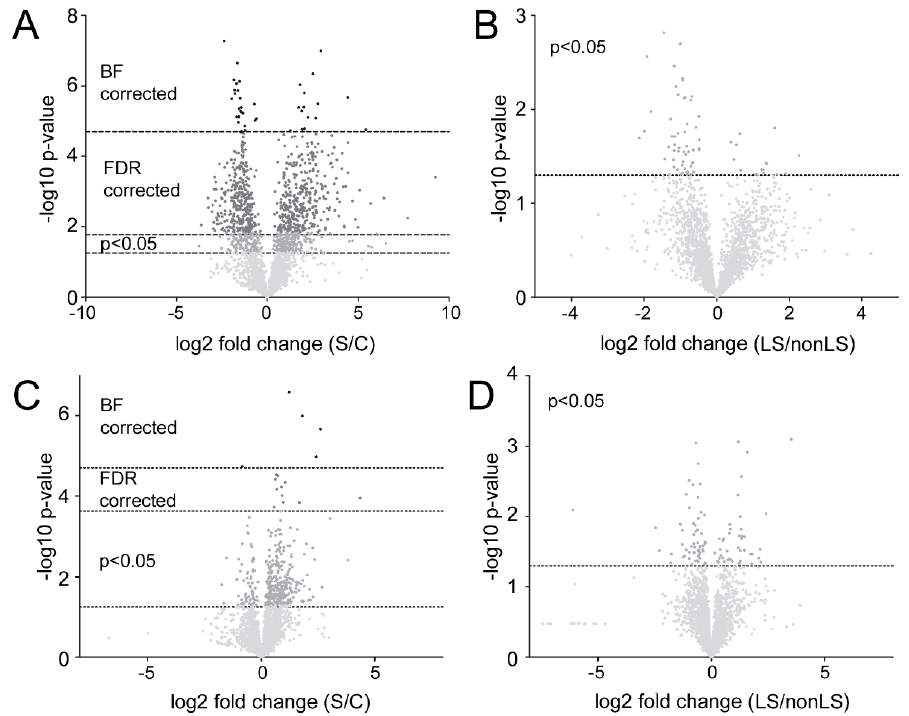
Figure 4. Volcano plots of the data. ( A ) Volcano plot of BALF-controls vs. BALF-sarcoidosis. Negative fold change signifies control correlation, positive fold change indicates sarcoidosis correlation. ( B ) Volcano plot of BALF-LS vs. BALF-nonLS. Negative fold change signifies nonLS correlation, positive fold change indicates LS correlation. ( C ) Volcano plot of the serum-controls vs. serum-sarcoidosis. Negative fold change signifies control correlation, positive fold change indicates sarcoidosis correlation. ( D ) Volcano plot of the serum-LS vs. serum-nonLS. Negative fold change signifies non-LS correlation, positive fold change indicates LS correlation. Significance is indicated by Bonferroni (BF) correction, FDR correction, and p < 0.05. The BF correction was adjusted to the total number of variables ( n = 1711) giving a cut off of 4.71. The FDR was corrected according to the p-value distribution for each data set separately. The big difference in FDR correction between Figure 4A, (cut off = 1.77) and Figure 4C (cut off = 3.63) is due to the much larger portion of variables in the BALF that were significantly different ( p < 0.05) between controls and patients compared to what was observed in the